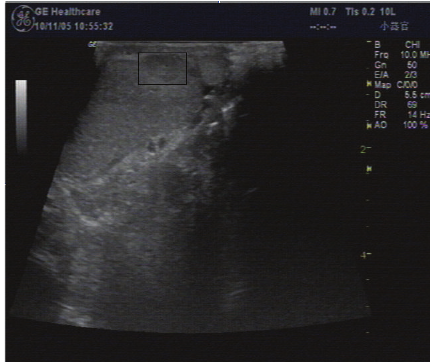
Figure 1: Scrotal ultrasonography of AT: scrotal ultrasound scan revealing a 10 × 8 mm, hyperechoic solid mass in the upper pole of the left